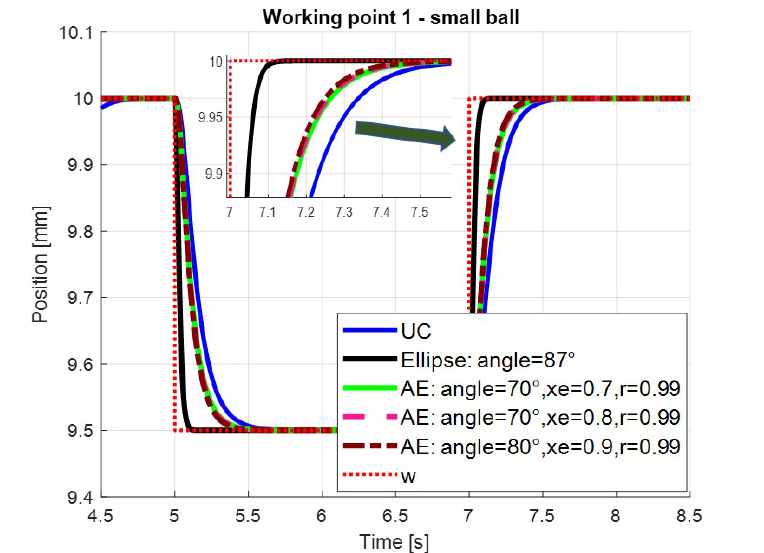
Figure 4. Step responses simulated on nonlinear model for the 1st working point (small ball) with the proposed pole-placement controllers according to legend.